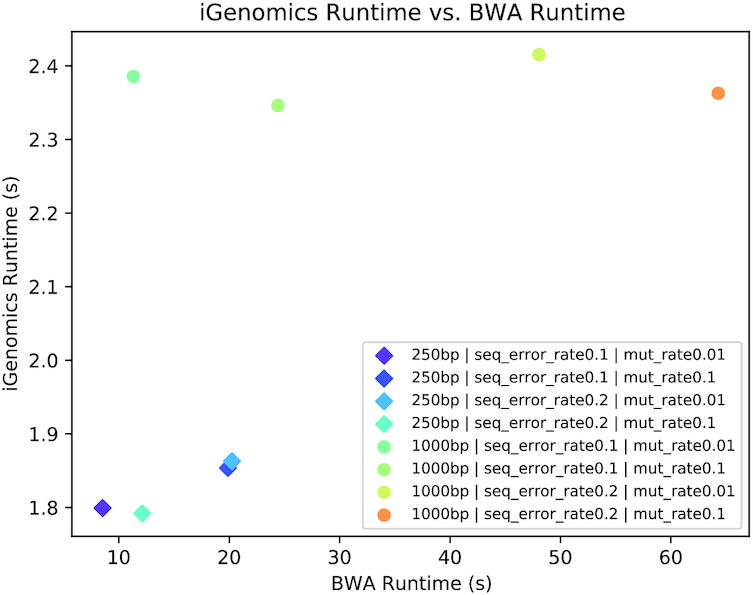
iGenomics runtime vs BWA/SAMtools pipeline runtime for simulated datasets of constant mutation rates and sequence error rates of H1N1 for varying read lengths.